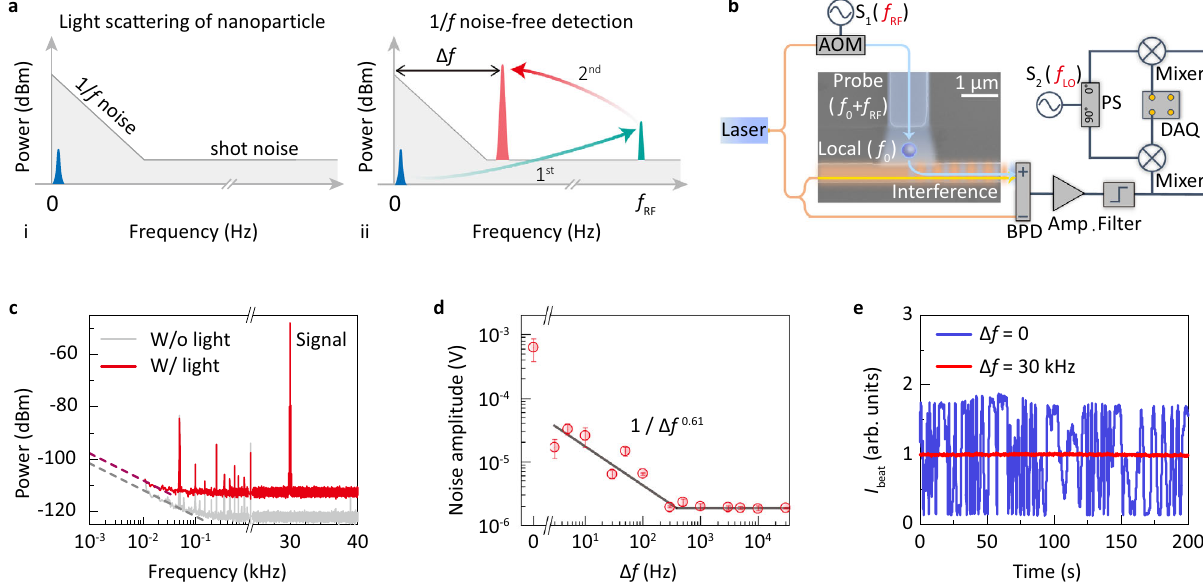
Fig. 1 1/ f -noise-free optical sensor. a A low-frequency light scattering signal induced by a nanoparticle buried in noise background (i), and the principle of 1/ f -noise-free detection (ii). Blue peak: original light scattering signal; green peak: the fi rst ampli fi ed signal after optical up-conversion process; red peak: the extracted signal after electrical ampli fi cation and down-conversion processes. b Experimental set-up. BPD balanced photodetector, S 1 and S 2 signal generators with f RF = 80.15 MHz and f LO = 80.18 MHz, respectively; AOM acousto-optic modulator, Amp. radio-frequency ampli fi er, PS 90 ∘ power splitter, DAQ data acquisition system. c Power spectra of A I at low frequency region when both probe and local light are off (gray curve) or on (red curve). The beat low-frequency noise fl oor is fi tted by 1/ f (dashed curves). d The sampling noise amplitude versus bias frequency Δ f . Red circles: experimental data; black curve: 1/ f 0.61 fi tting below the corner frequency. Error bars represent the standard deviation of repeated measurements. e Beat intensity I beat for the conventional lock-in amplifying scheme ( Δ f = 0, blue curve) and the 1/ f -noise-free regime ( Δ f = 30 kHz, red